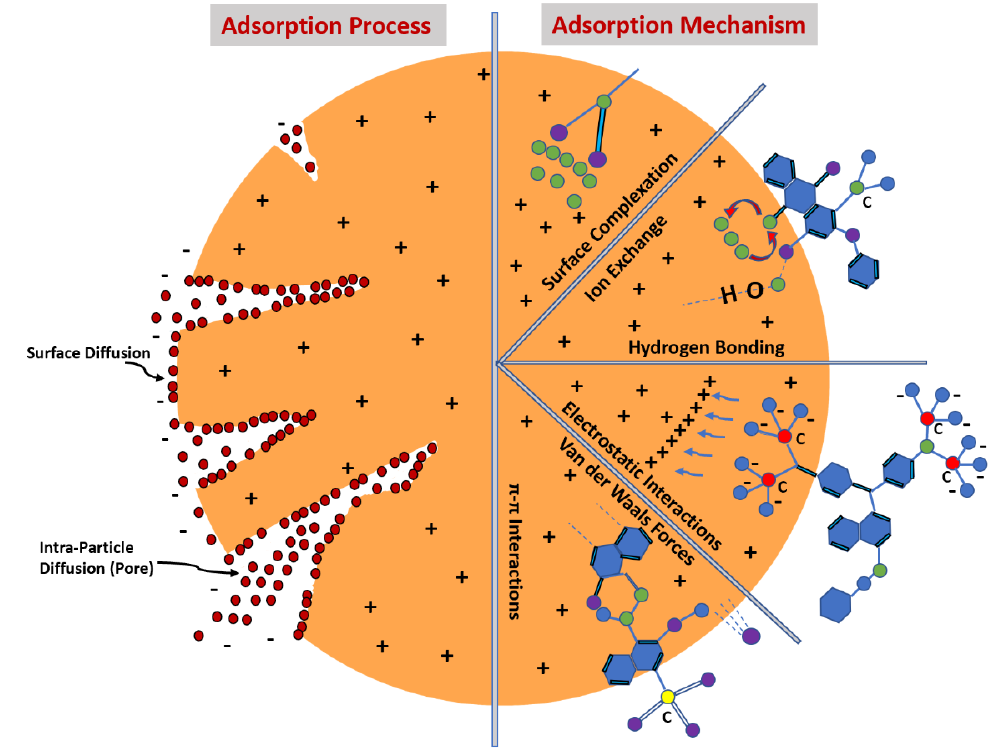
Figure 4. Mechanism and adsorption process for the elimination of dye (MB).